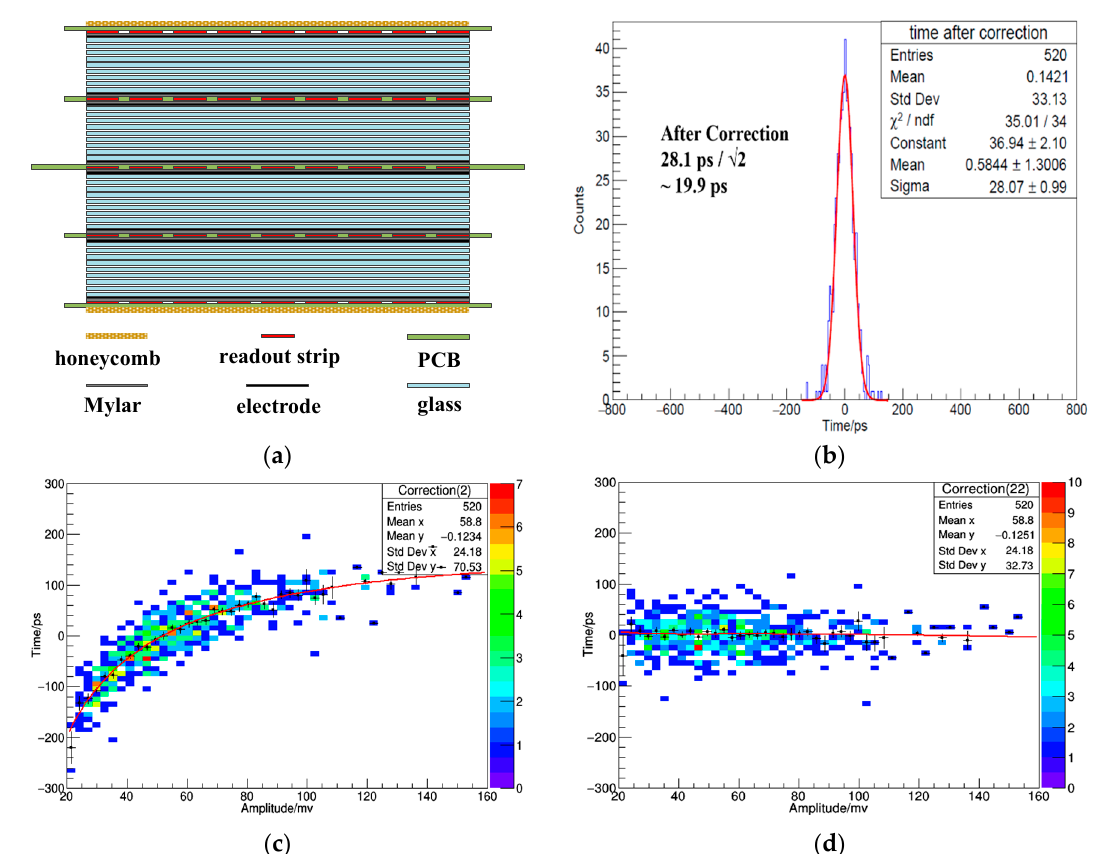
Figure 13. ( a ) Schematic picture of the 32-gap MRPC. ( b ) The time distribution and resolution results of the cosmic test. The blue line shows the distribution of the time difference and the red line is obtained from the gaussian fitting. The relationship between the crossing time of the signal and the amplitude before ( c ) and after ( d ) the slewing correction. The red line is fitted by Equation (6). The mean values and error bars of each x-axis bin are shown. Reproduced with permission from Yu et al., Journal of Instrumentation; published by IOP Publishing for Sissa Medialab, 2020 [90].